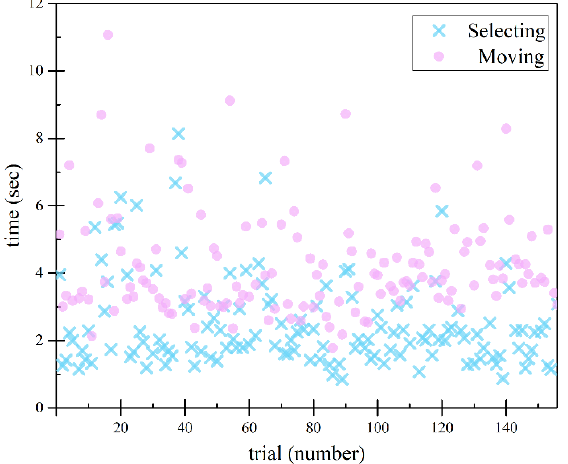
Figure 9. Interaction time measured during experiment.